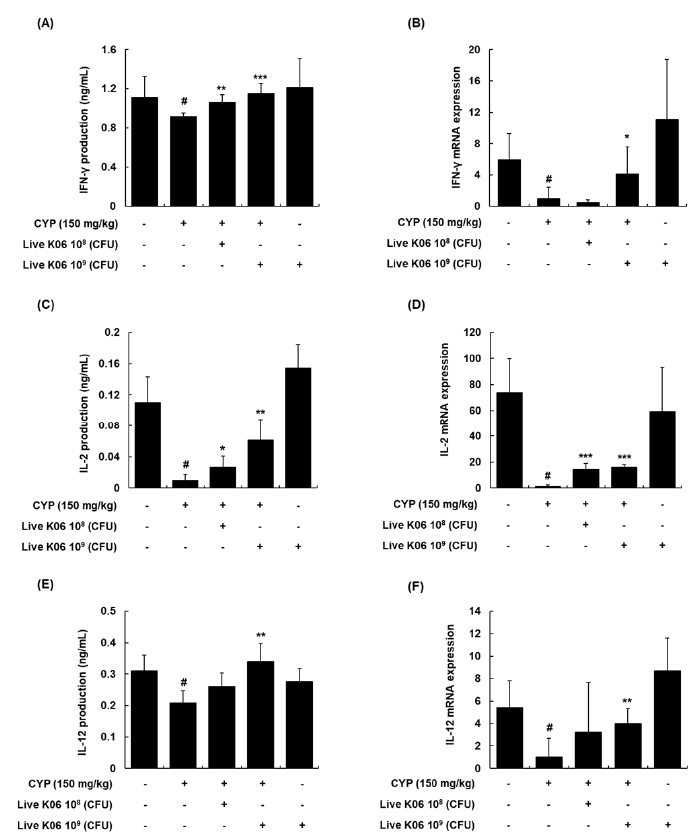
Figure 4. Effects of live K040706 on the production and mRNA expression of interferon (IFN)- γ , IL-2, and IL-12 in CYP-treated mice. ( A ), ( C ), and ( E ) Splenocytes were obtained and treated with Con A for 48 h. After incubation, the culture supernatant was collected and analyzed with ELISA for IL-2, IFN- γ , and tumor necrosis factor (TNF)- α production. ( B ), ( D ), and ( F ) The mRNA expression levels of the cytokines in the splenocytes were determined using qRT-PCR. Data are presented as mean ± SD of 10 mice. # p < 0.05 vs. vehicle-treated control mice; * p < 0.05, ** p < 0.01, and *** p < 0.001 vs. CYP- treated mice.